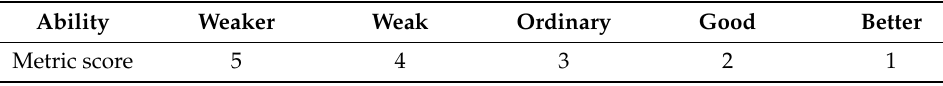
Table 6. Emergency response capacity